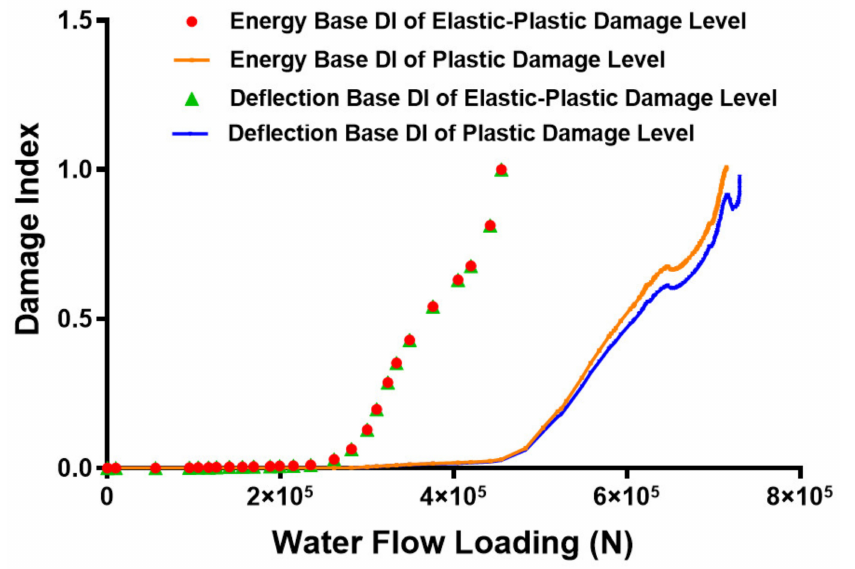
Figure 13. Comparison of the displacement and energy concepts of the elastic-plastic and fully plastic damage